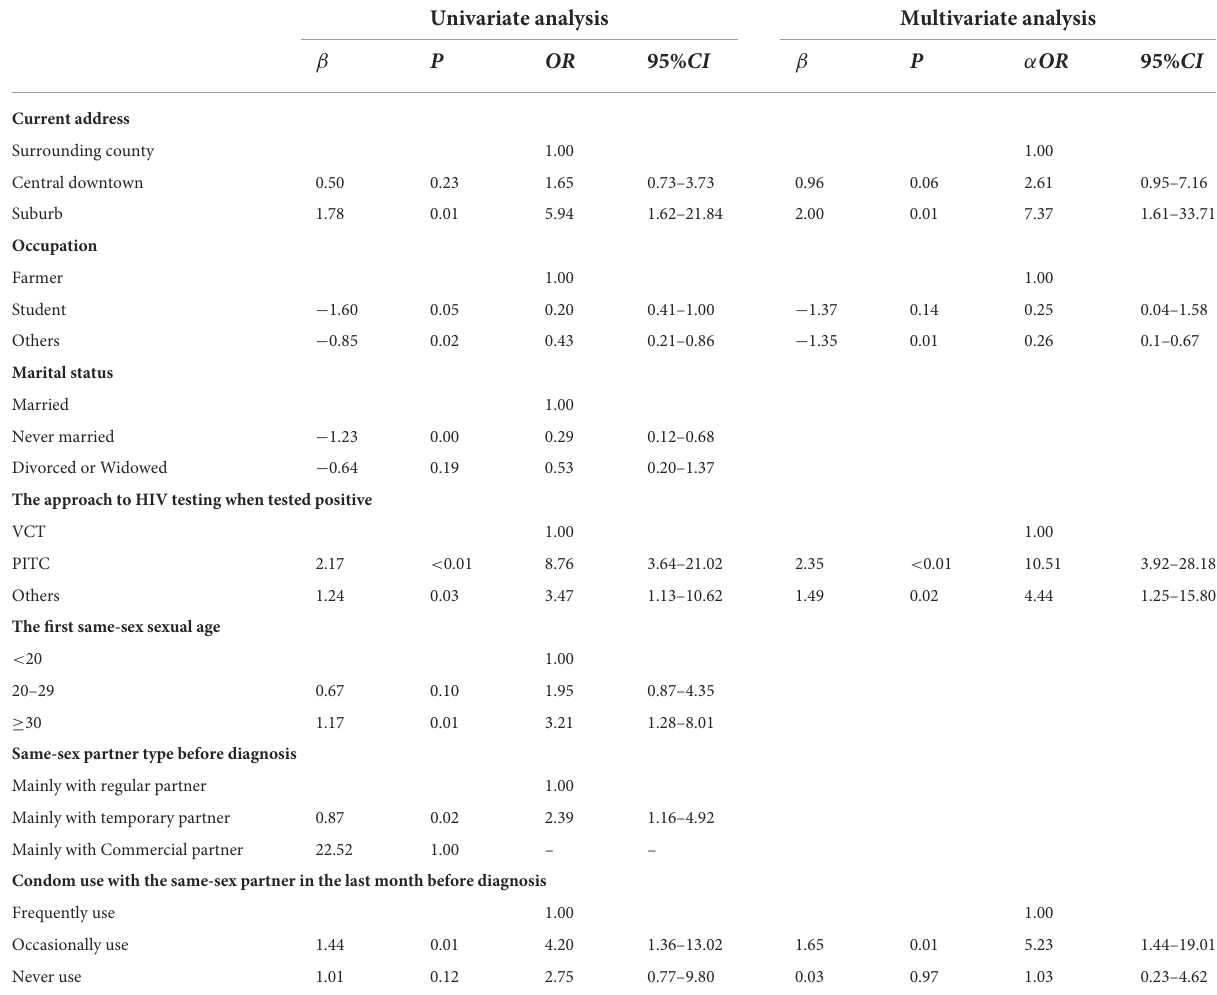
TABLE 3 Factors correlated with disclosure of same-sex behaviors after medical care. Univariate analysis Multivariate